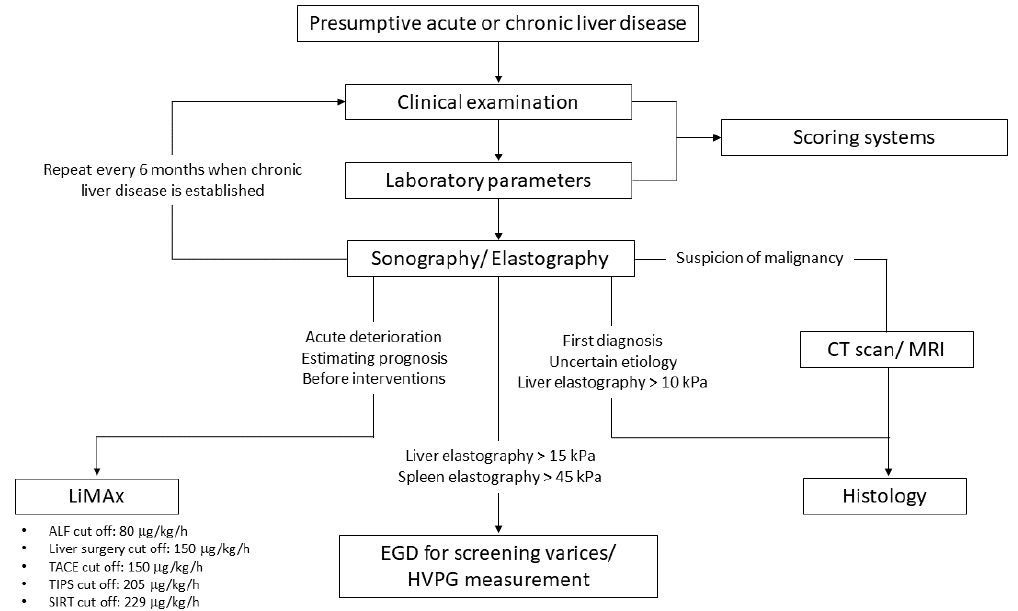
Figure 3. Proposed algorithm in individuals with presumptive acute or chronic liver disease.